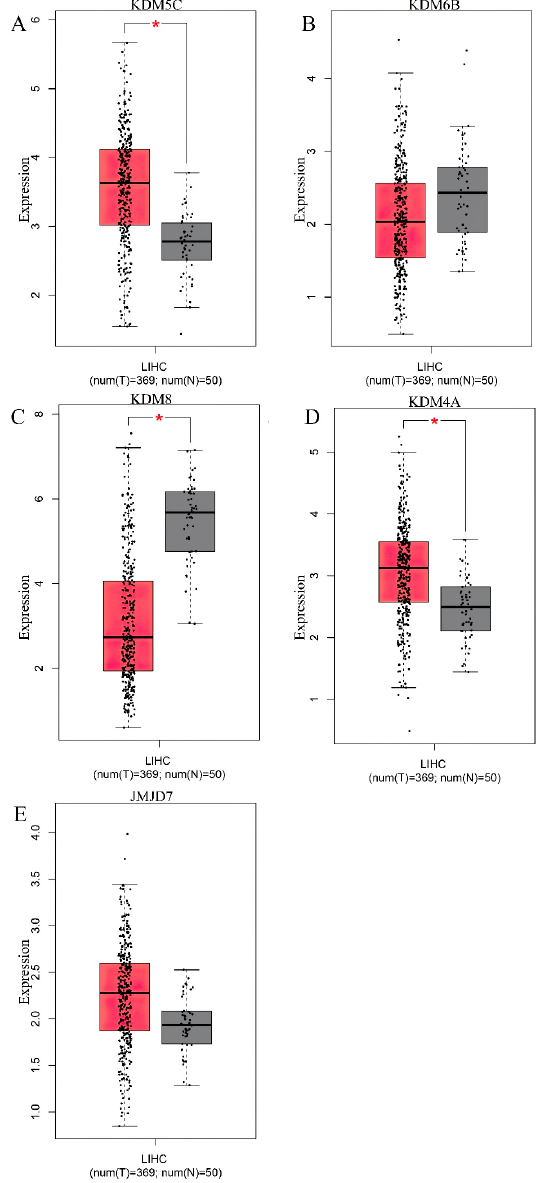
Figure 4. HDM gene expression in HCC versus normal tissues. ( A ) KDM5C. ( B ) KDM6B. HCC, hepatocellular carcinoma; LIHC, liver hepatocellular carcinoma. An asterisk indicates that